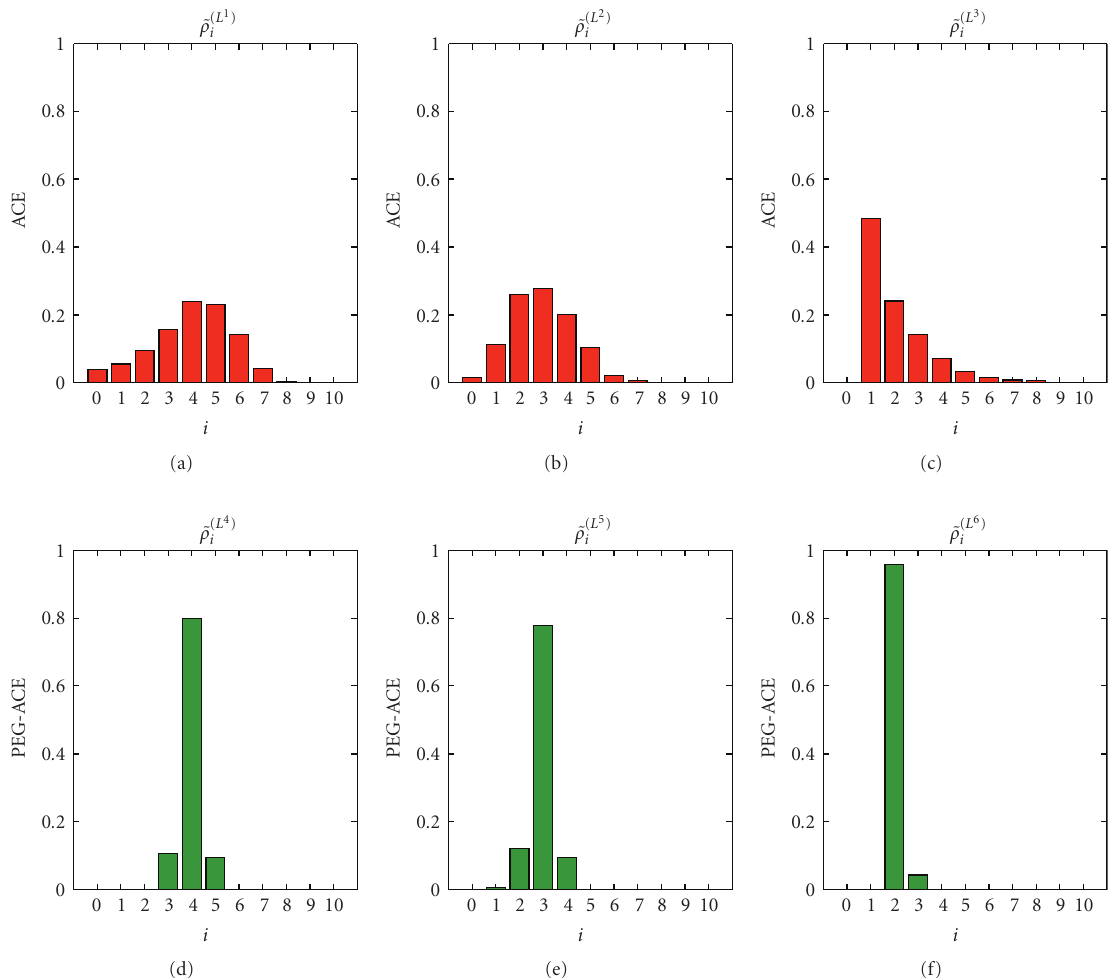
Figure 6: Detailed check-node degree distribution coe ffi cients for the codes constructed by the ACE and the PEG-ACE algorithms.